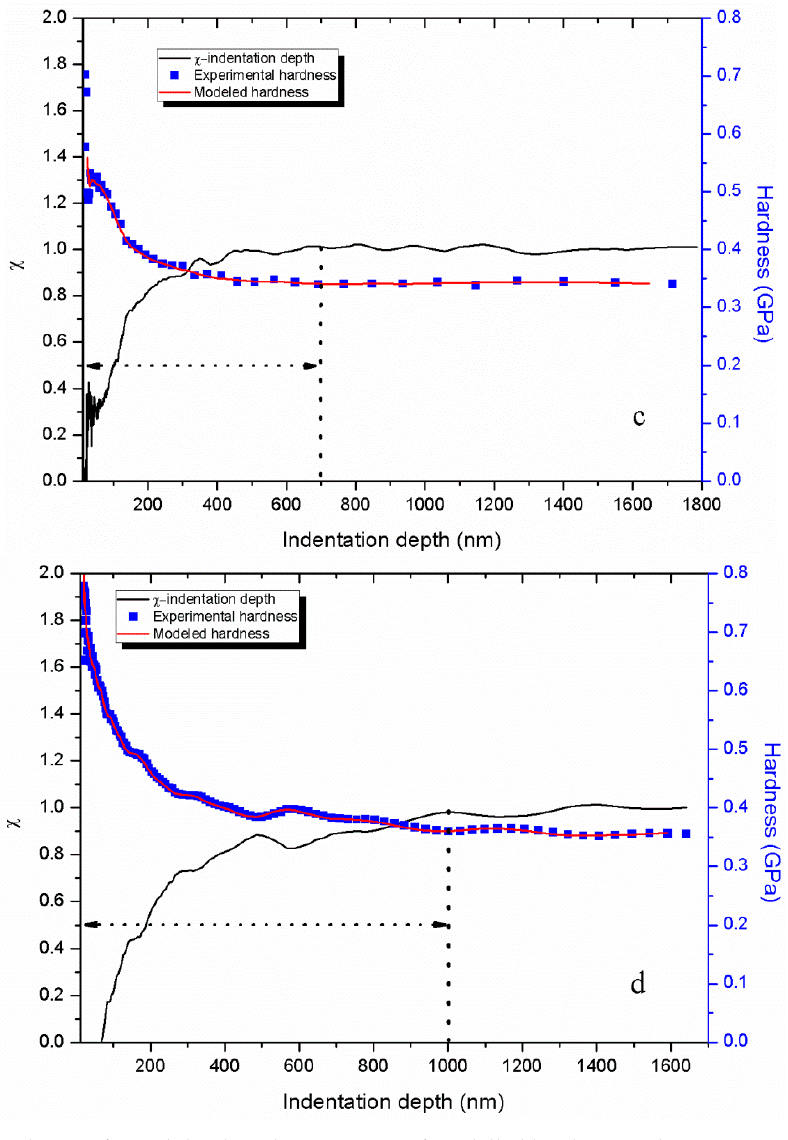
χ Figure 10. Relation of χ and depth and comparison of modelled hardness and experimental hardness Figure 10. Relation of and depth and comparison of modelled hardness and experimental with depth for the yield criteria of f ( I 1 , J 2 , J 3 ) at different strain rates of 0.004 s − 1 ( a ), 0.008 s − 1 ( b ), hardness with depth for the yield criteria of 1 2 3 ( , , ) f I J J at different strain rates of 0.004 s –1 ( a ), 0.016 s − 1 ( c ) and 0.024 s − 1 ( d ). 0.008 s –1 ( b ), 0.016 s –1 ( c ) and 0.024 s –1 ( d ). Table 3. Average modulus and hardness values calculated from different depth ranges under four strain